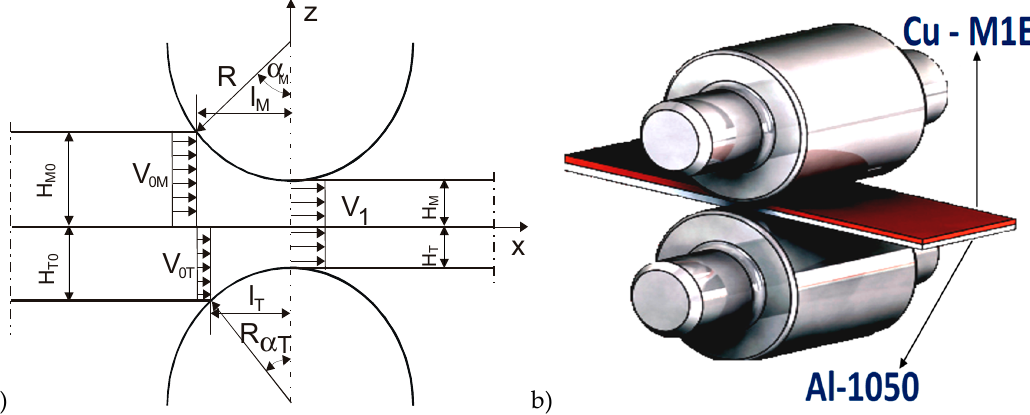
Figure 4. Asymmetrical rolling process of Al-1050 + Cu-M1E bimetallic sheets. ( a ) scheme of rolling process of bimetallic sheet with marked characteristic values, ( b ) schematic view of bimetallic sheet rolling process. Based on own study [7–9].